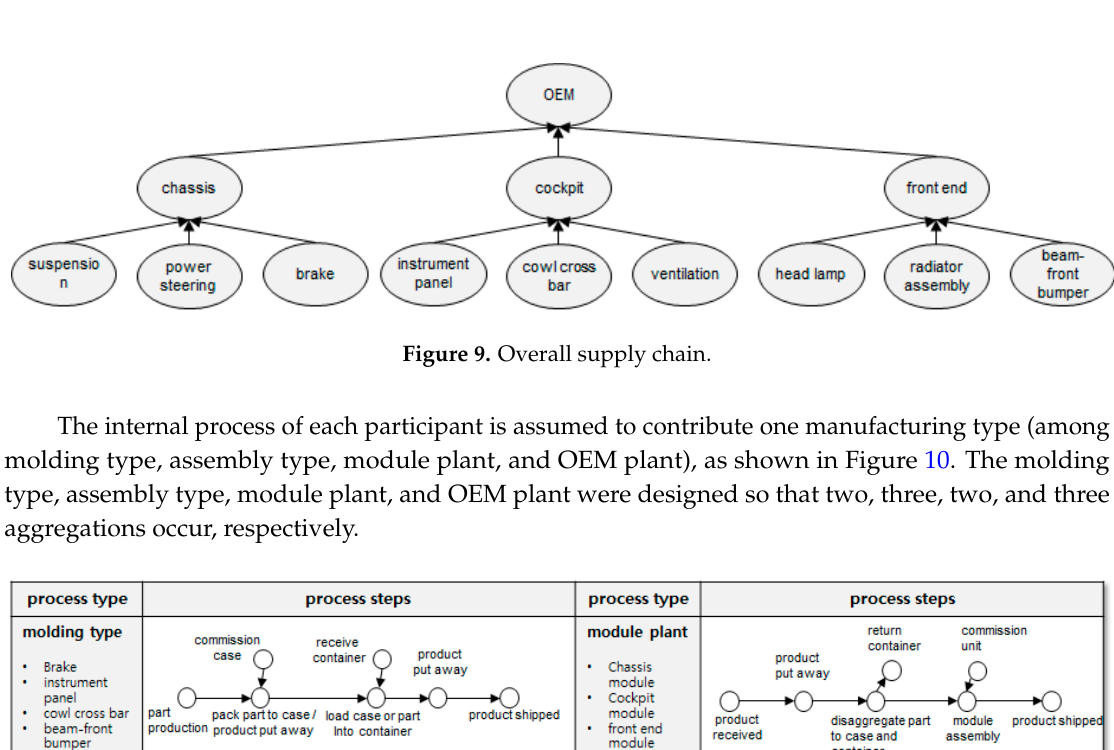
Figure 10. Internal processes according to manufacturing type.